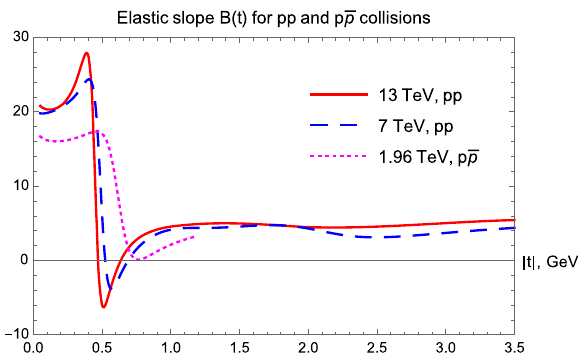
√ s = 13 and √ s = 1.96